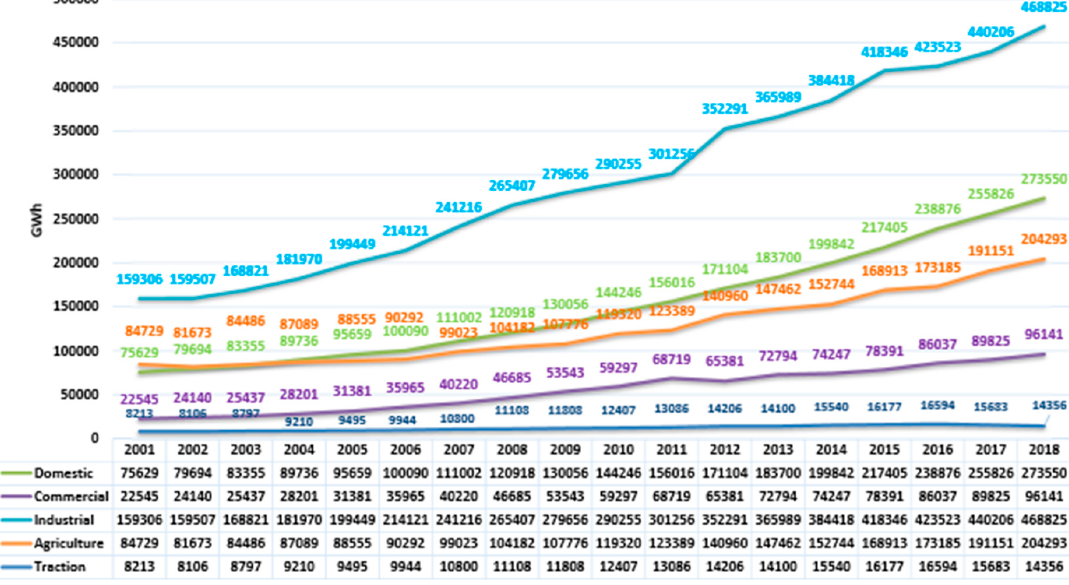
Figure 2. Sector wise Energy Consumption since the Century (2000–2018).